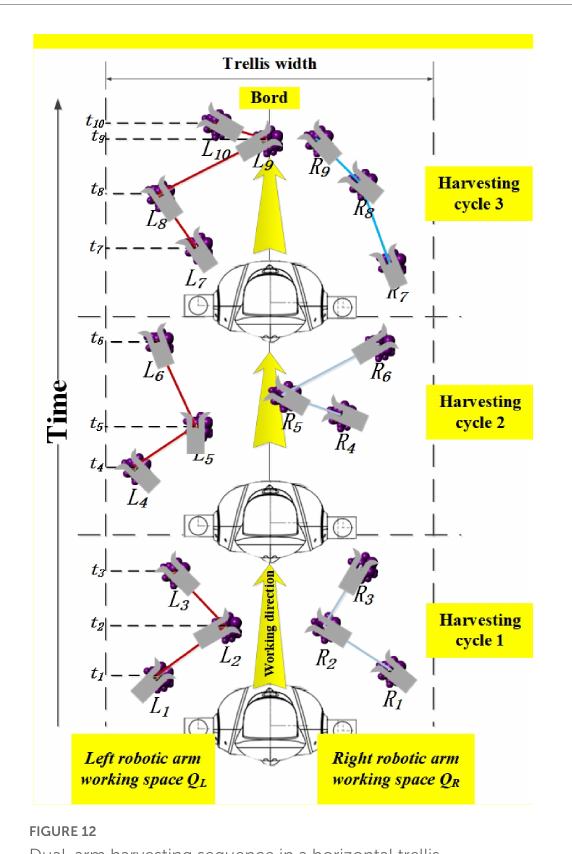
Robotic arms are used as electrical devices with independent control centers. Dual arms may be prone to collision and even serious damage. Therefore, we defined a dual-arm operating space and established a danger area and safe area in the working